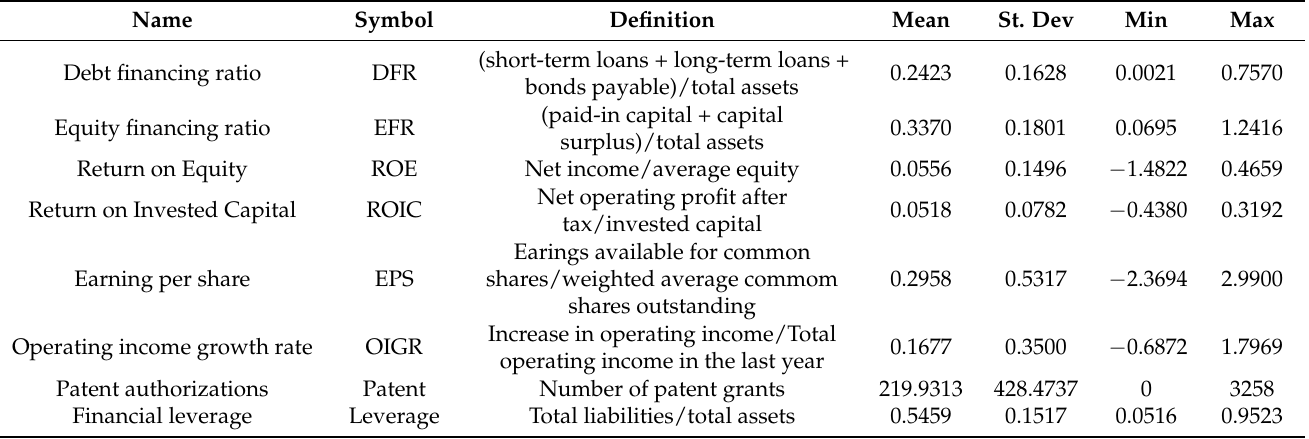
Table 1. Descriptive statistics.